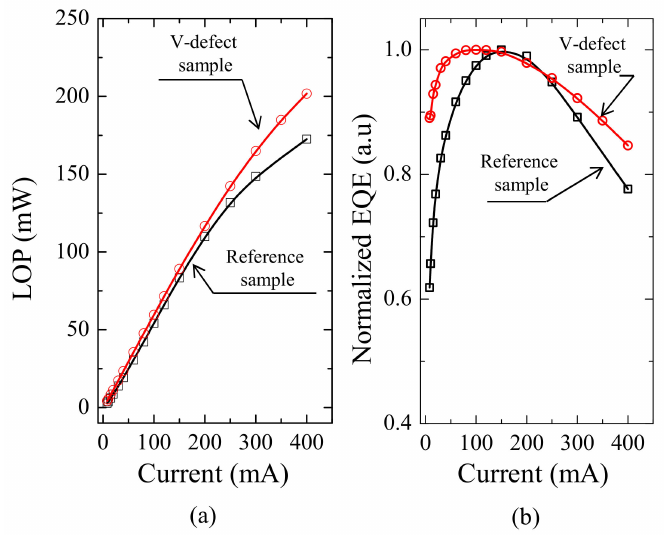
Figure 9. ( a ) LOP and ( b ) normalized EQE as a function of current for V-defect sample (circle) and reference sample